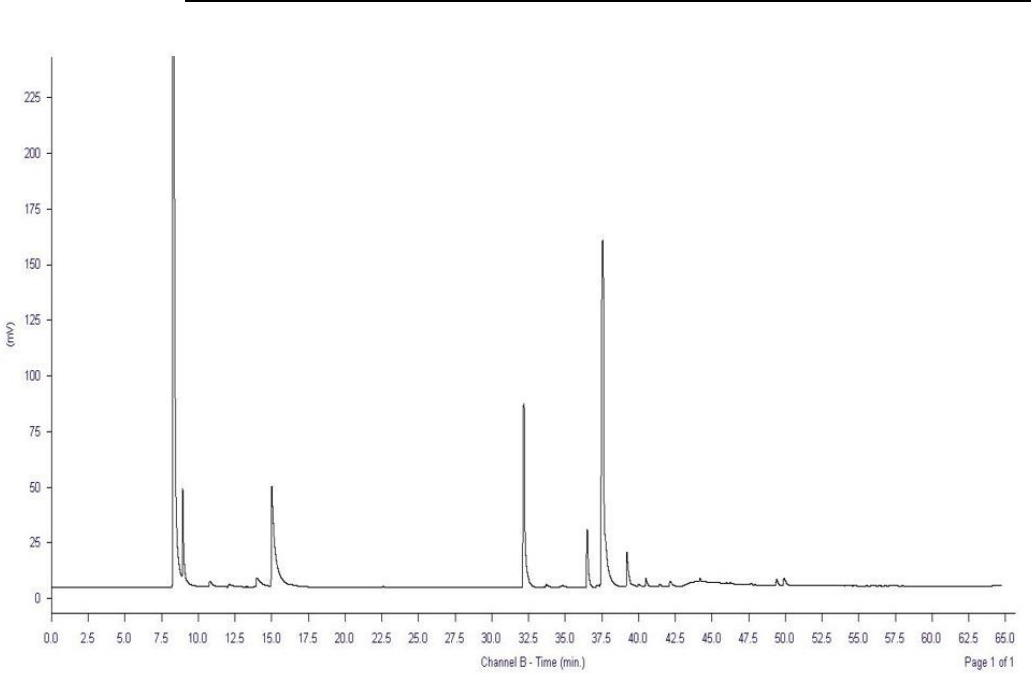
Figure 1. GC chromatogram of ozonated olive oil (OL).